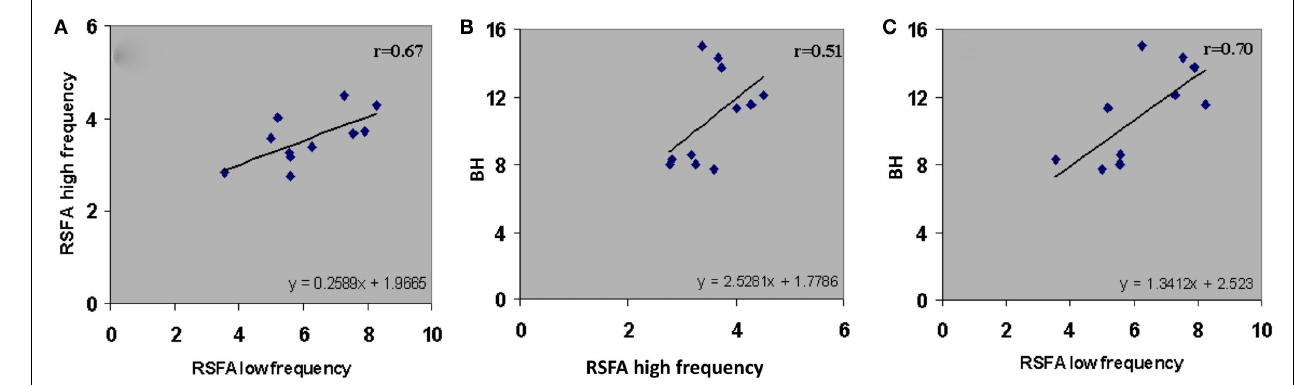
P < 0.01). A strong linear relationship was observed from the voxel-averaged BOLD signals at the subject level.The relationship indicates a significantly higher vascular component in the low frequency RSFA compared to high frequency RSFA.